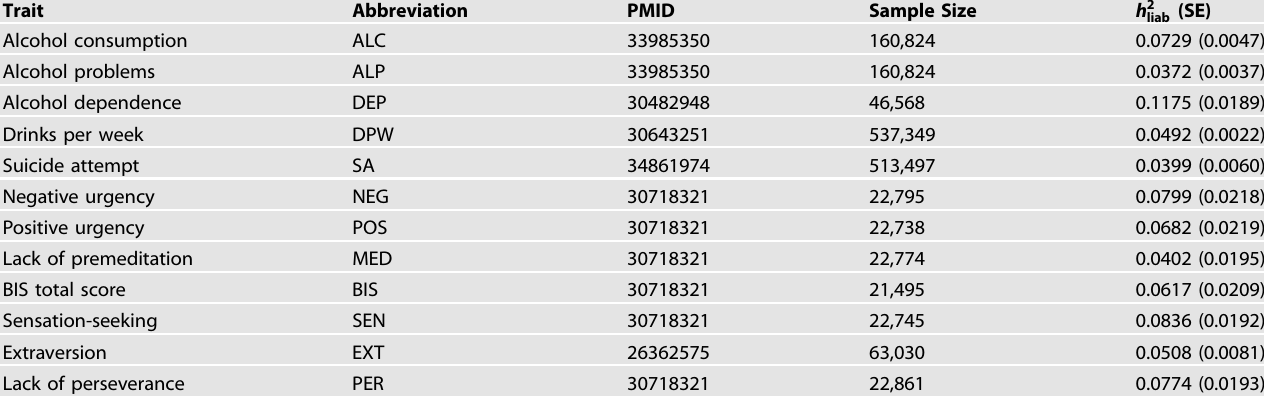
Table 1. Descriptive statistics for genome-wide association studies of alcohol-related outcomes, suicide attempt, and impulsive personality